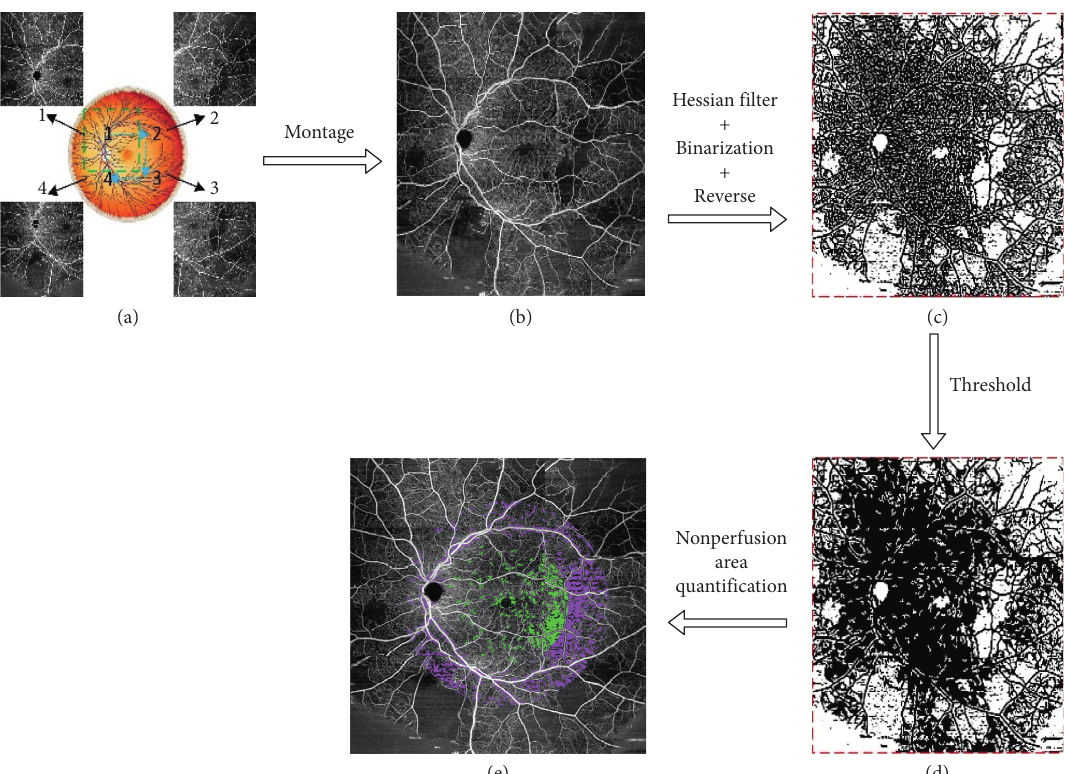
Figure 1: Optical coherence tomography angiography (OCTA) measurements and scanning protocol. Flowchart showing OCTA mea- surements and scanning protocol. (a) Four 12mm × 12mm scans were used to complete a wide field of view (FOV) image for each participant, (b) the original wide FOV image of retinal blood flow, (c) the nonvessel map, (d) the nonperfusion area map, and (e) the quantification results map; green: nonperfusion area in 30 ° FOV quantification region and purple: nonperfusion area in 60 ° FOV quantification